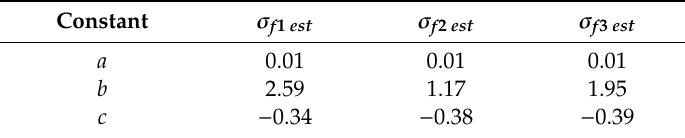
Table 3. Constants to estimate the improved fatigue strength of the Ti6Al4V manufactured by DMLS and EBM through mechanical surface treatment using the surface roughness, surface hardness, and surface residual